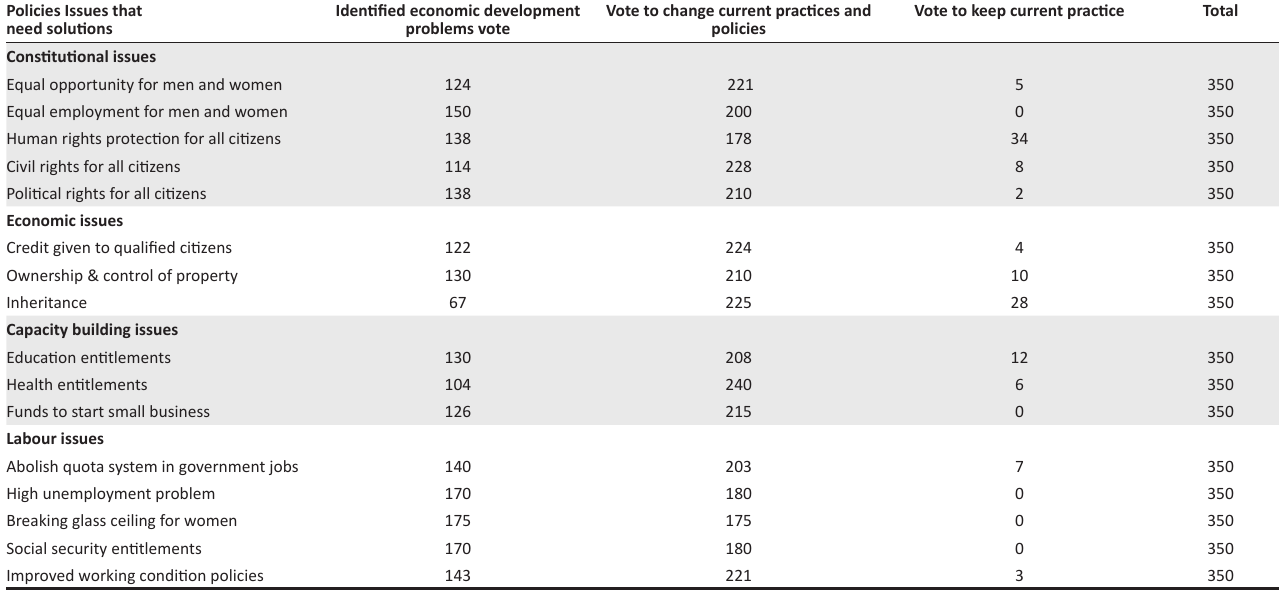
Table 7: Number of statements made by focus group question respondents. Policies Issues that need